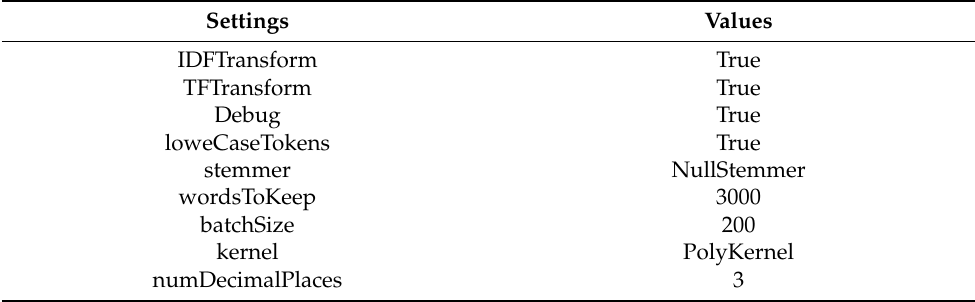
Table 5. The settings of the SVM1 model training.